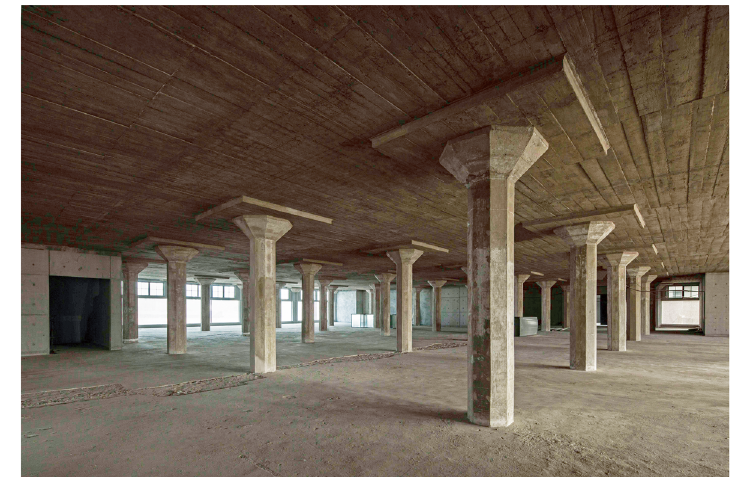
Fig. 9 Renovated beamless structural system of the interior (Source: Tianzhou